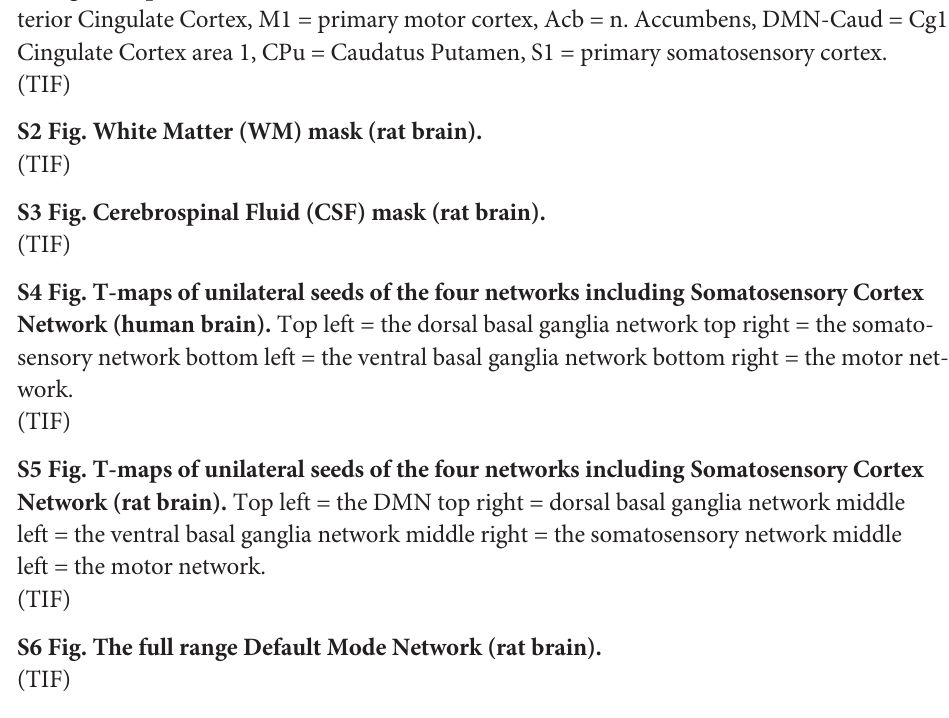
S1 Fig. Seed placement (rat brain). DMN-Rost = PrL; Prelimbic Cortex, RACC = Rostral An- terior Cingulate Cortex, M1 = primary motor cortex, Acb = n. Accumbens, DMN-Caud = Cg1; Cingulate Cortex area 1, CPu = Caudatus Putamen, S1 = primary somatosensory cortex.